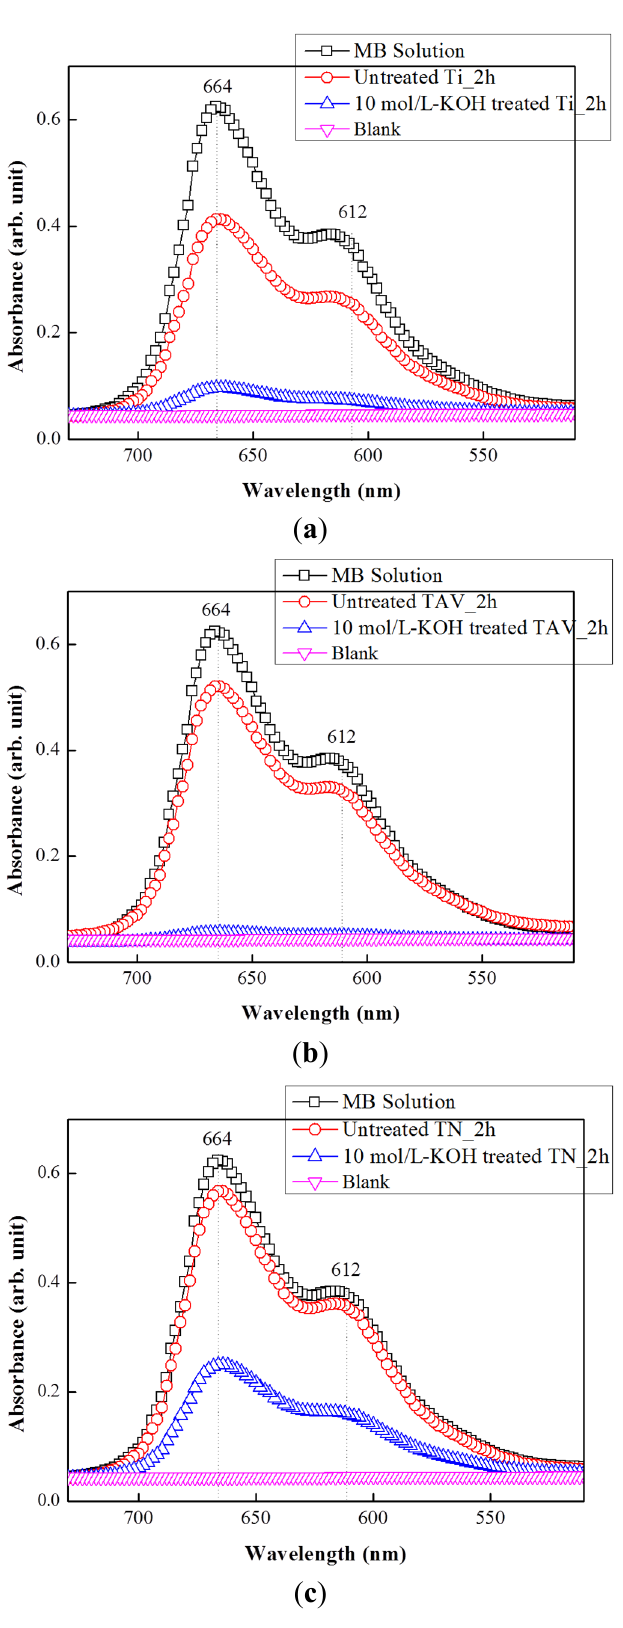
Figure 7. UV-vis absorption spectra of MB solution in the presence of the K-incorporated nTOFs and untreated sample. The intensity of the main absorption peak at 664 and 612 nm reflects the MB. The peak decreased after 2 h of degradation as a blank level, indicating the efficiency of a